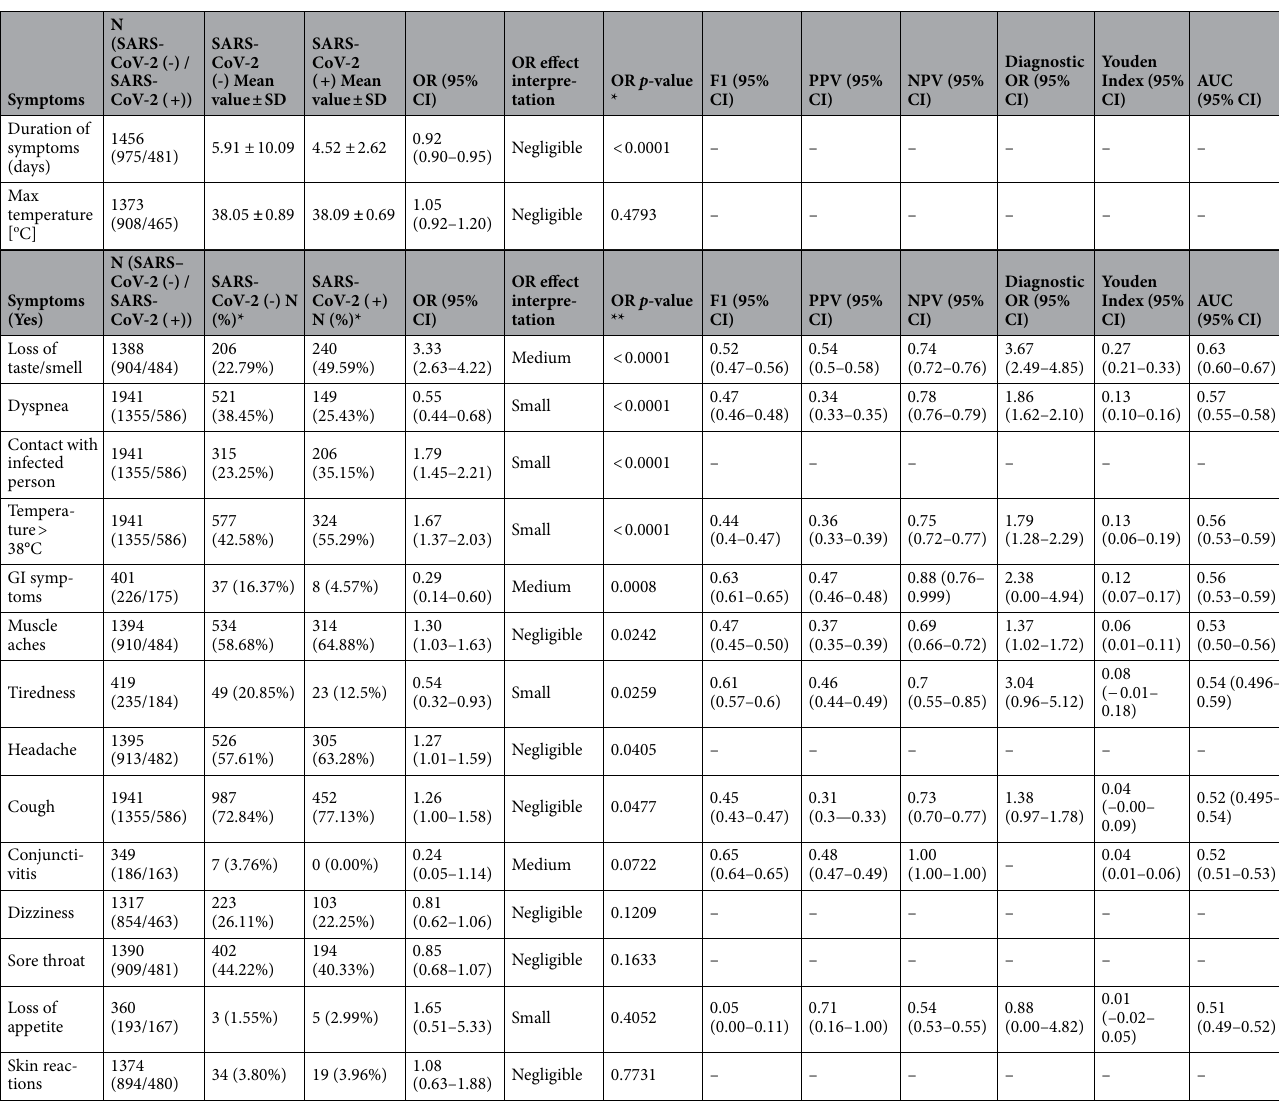
Table 3. The differences in prevalence of studied symptoms between patients positive and negative for SARS- CoV-2 and the quality indices for the logistic regression based predictor for the chosen single symptoms (obtained from tenfold cross-validation). * % calculated referring to N of particular characteristics in SARS- CoV-2(-) and SARS-CoV-2( +). ** Unadjusted